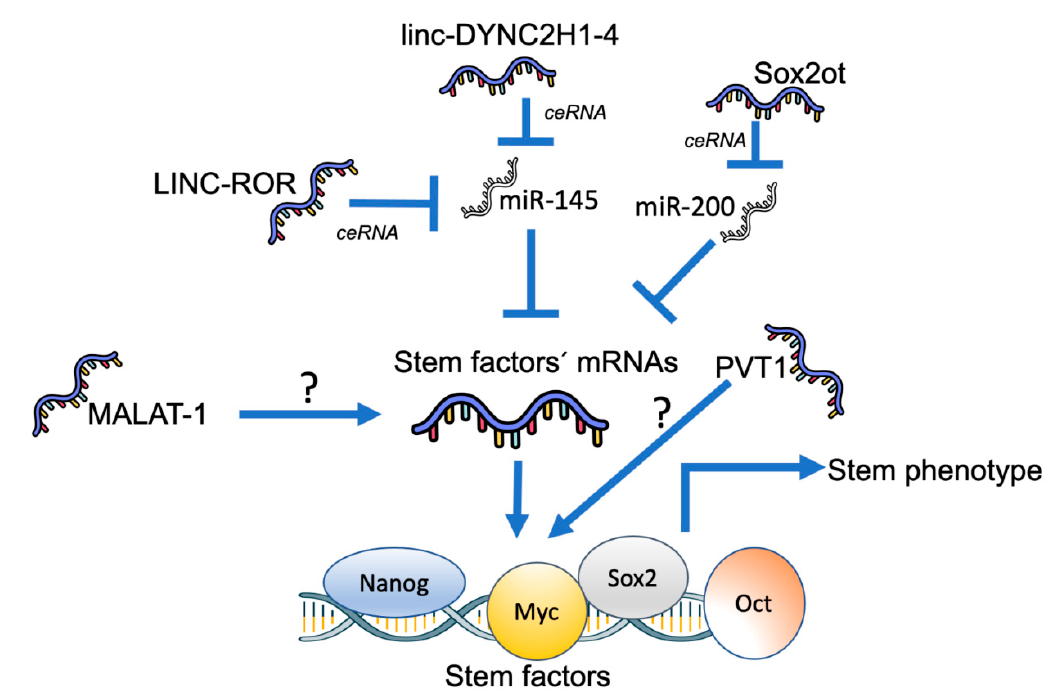
Figure 2. Several lncRNAs modulate the stem phenotype of pancreatic cancer stem cells by a direct effect on stem factors such as Nanog, Myc, Sox2, Oct4, etc. The most common molecular mechanism for this effect is acting as a competing endogenous RNA toward specific microRNAs. There have been hundreds of ceRNA reported examples since the initial description of this mechanism [118]. In this scenario, a microRNA that downregulates a group of mRNAs is “sequestered” by a pseudogene or a lncRNA in order to decrease its activity. This effect is thus a way to create a large-scale regulatory network.